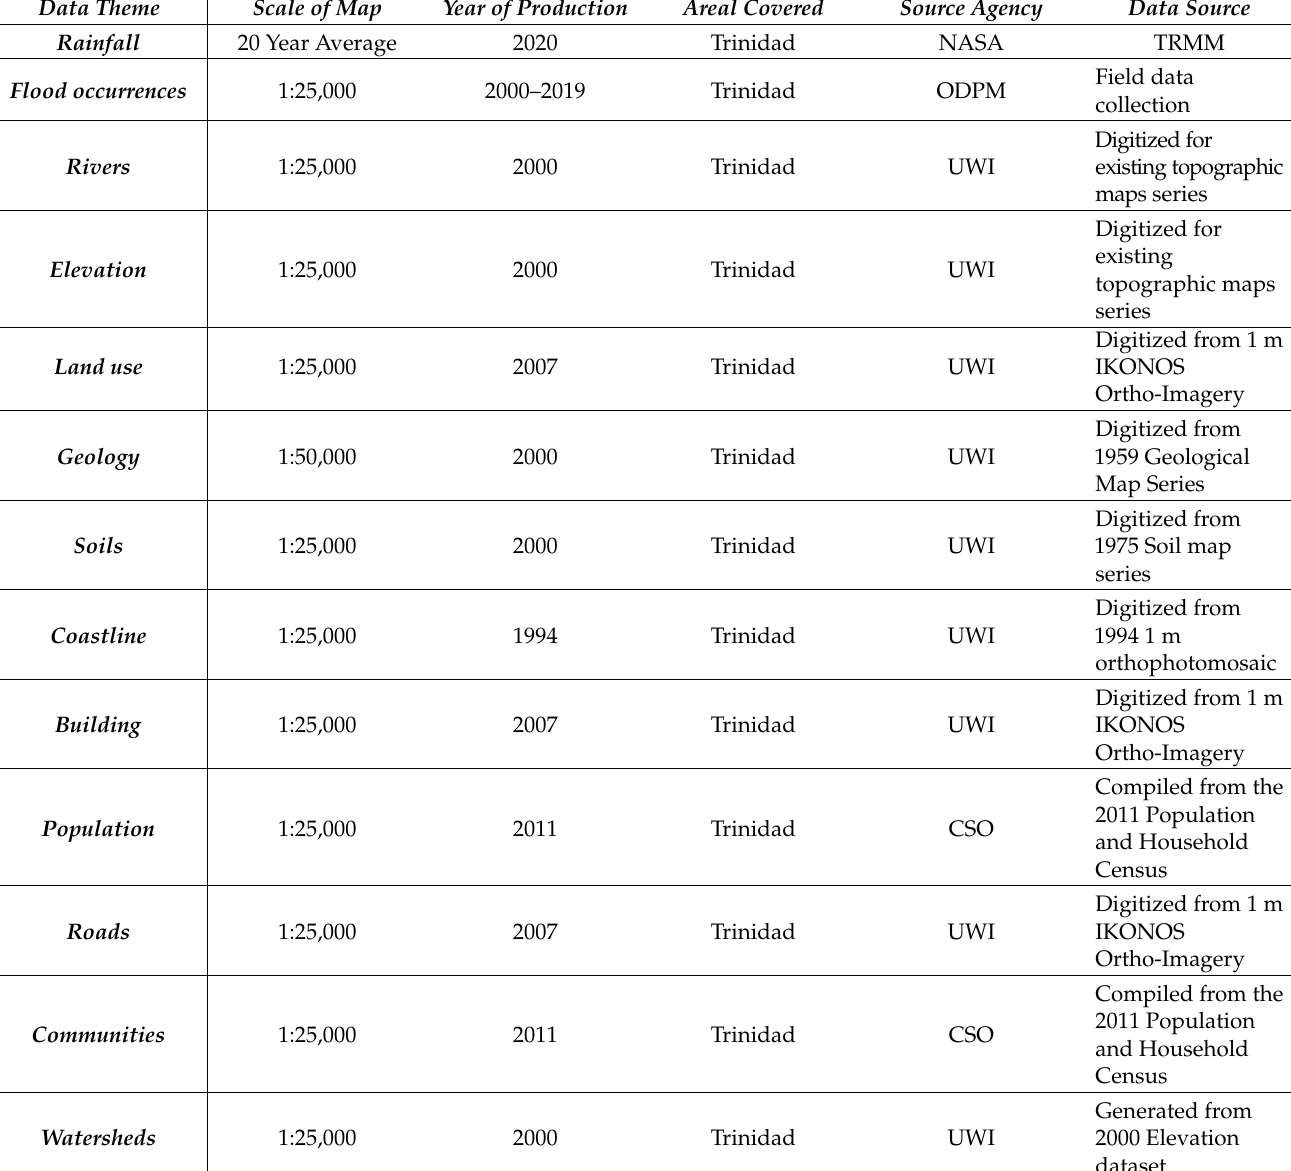
Table 1. Datasets used and its